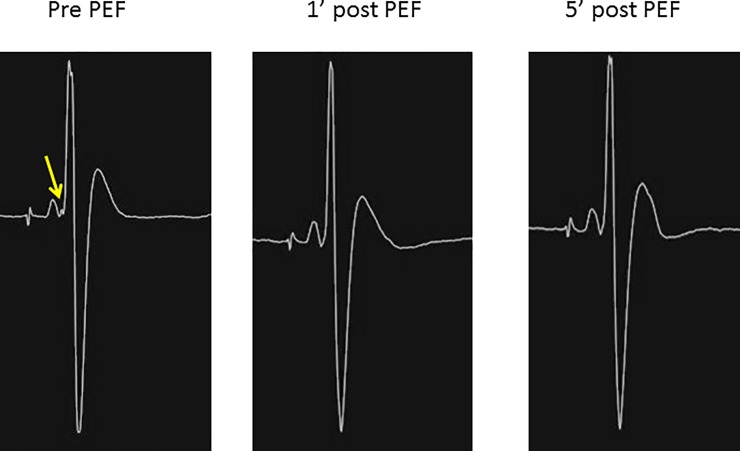
Loss of small Purkinje potential, but resistance of the His to PEF.